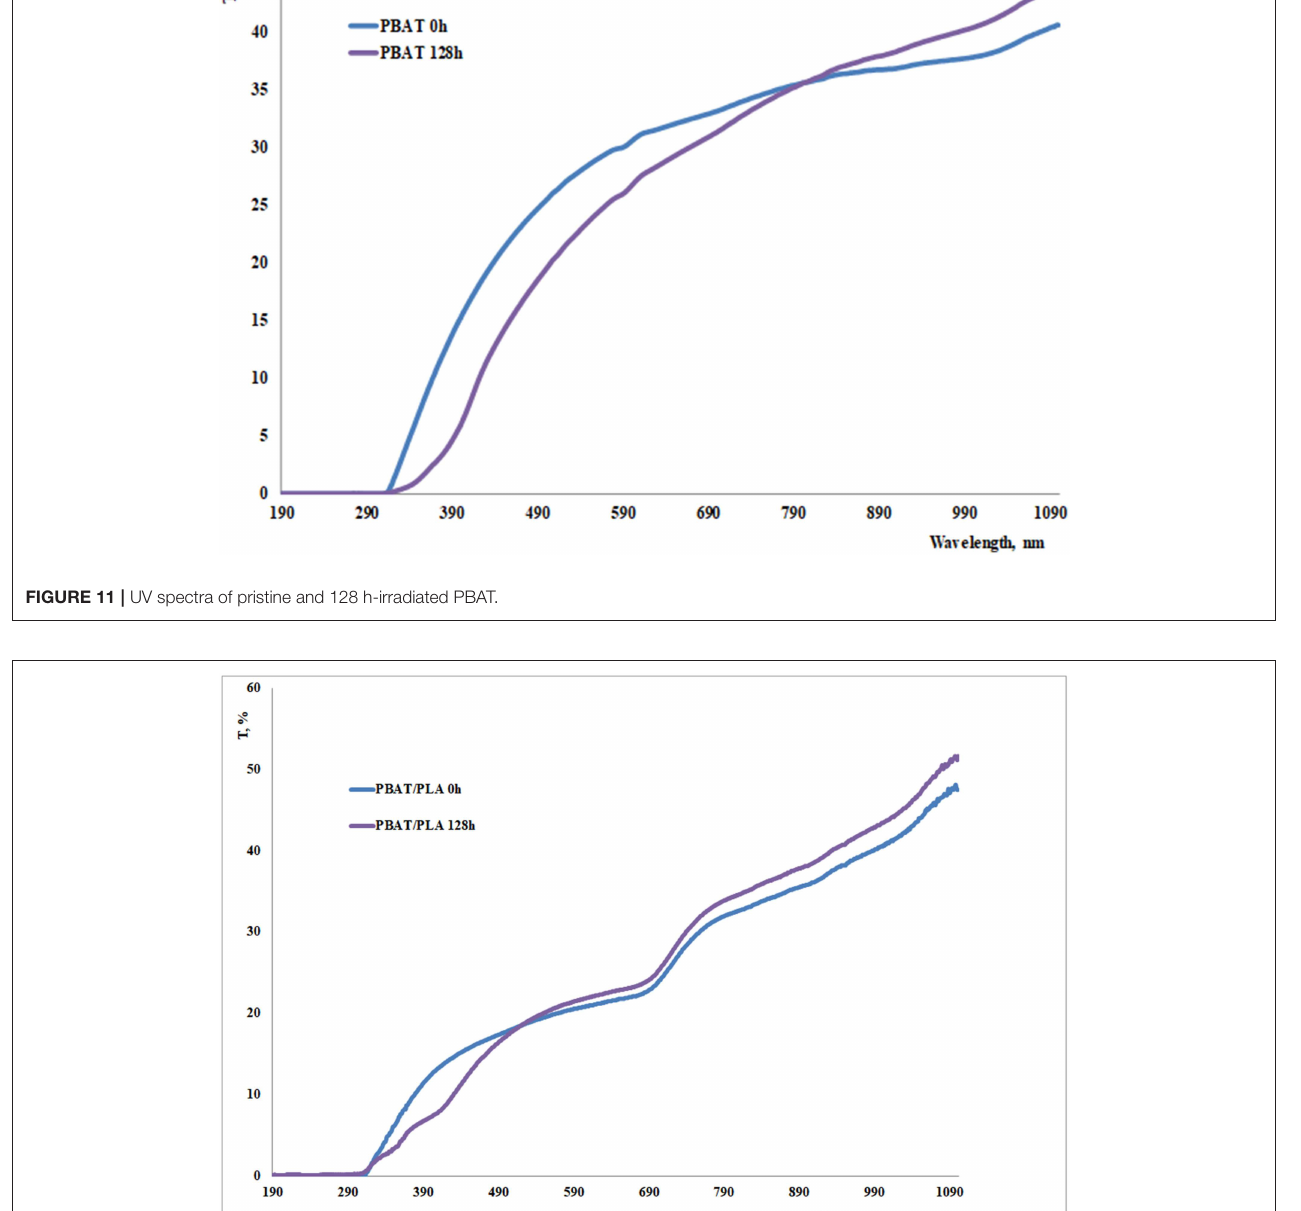
Frontiers in Materials |